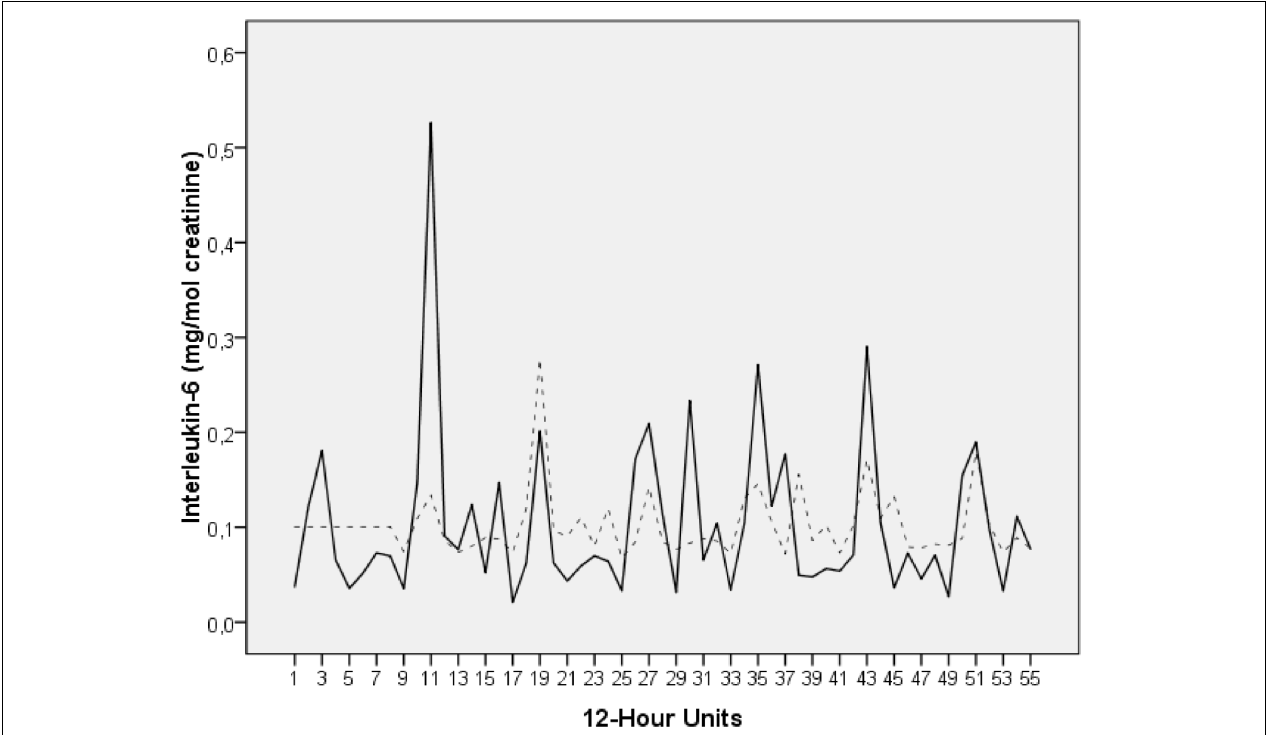
FIGURE 1 | Time series of urinary IL-6 levels of the breast cancer patient under study (milligram per mole creatinine). The time series covers a period of 28 days. During this time interval, the patient collected her entire urine in 12-h intervals, resulting in a total of 55 measurements (day portions from 8:00 a.m. to 8:00 p.m. and night portions from 8:00 p.m. to 8:00 a.m.). The raw data (solid black) and the fit from modeling the series (dotted grey) are plotted. The time series starts with a night